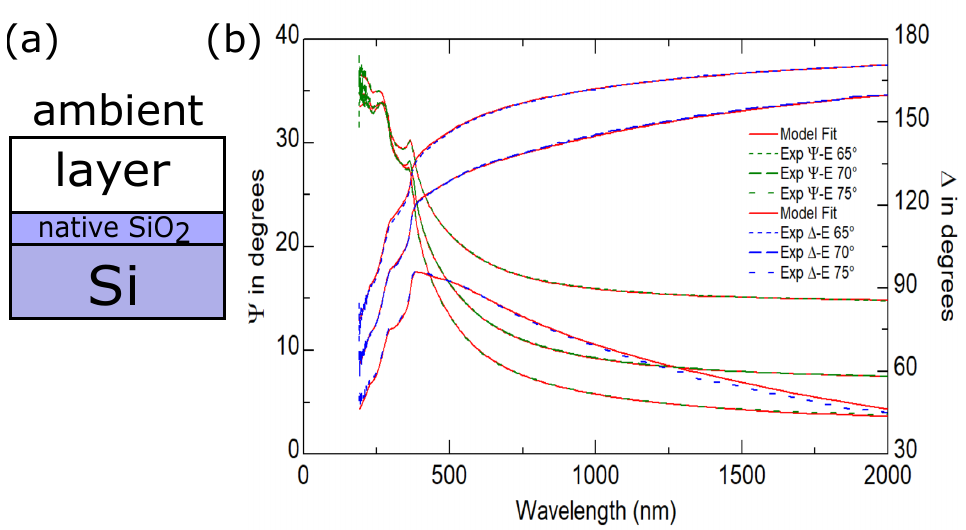
Figure 3. ( a ) Optical model of a sample. ( b ) Ψ and ∆ azimuths (experimental and calculated data) for the B1 (Si \ Sn(31)Au(19), Au:Sn = 1:1, T a = 200 ◦ C) specimen. The χ 2 value is